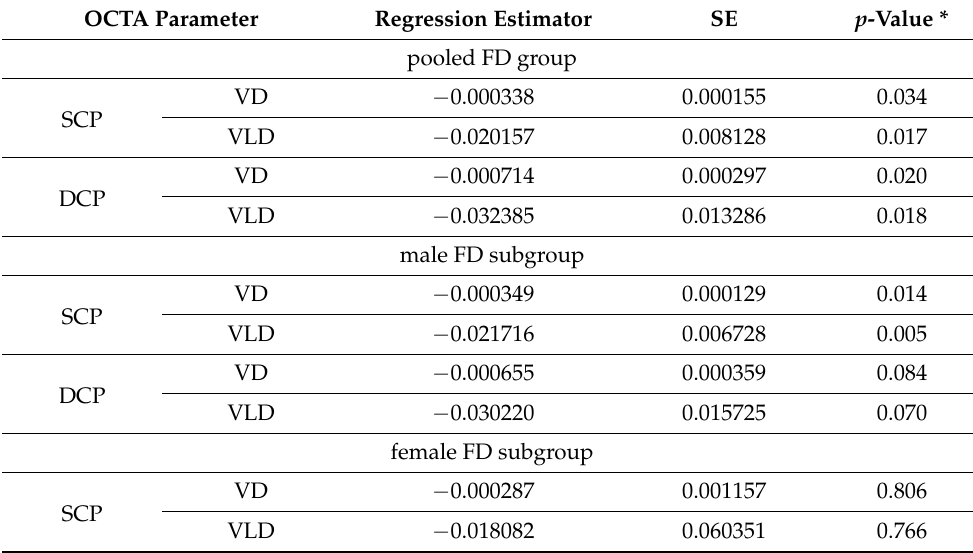
Figure 1. Scatterplots with centerline of VD and VLD in SCP and DCP of FD patients. In the upper left plot, the inverse association of VD in SCP with the logarithmized values of lysoGb3 (Ln.lysoGb3) is shown. The other plots show the inverse association for VLD in SCP (top right), VD in DCP (bottom left), and VLD in DCP (bottom right) with Ln.lysoGb3. Abbreviations: VD: vessel density; VLD: vessel length density; SCP: superficial capillary plexus; DCP: deep capillary plexus; FD: Fabry Disease; Ln.LysoGb3: logarithmized lysoGb3. Table 5. Association of lysoGb3 and OCTA